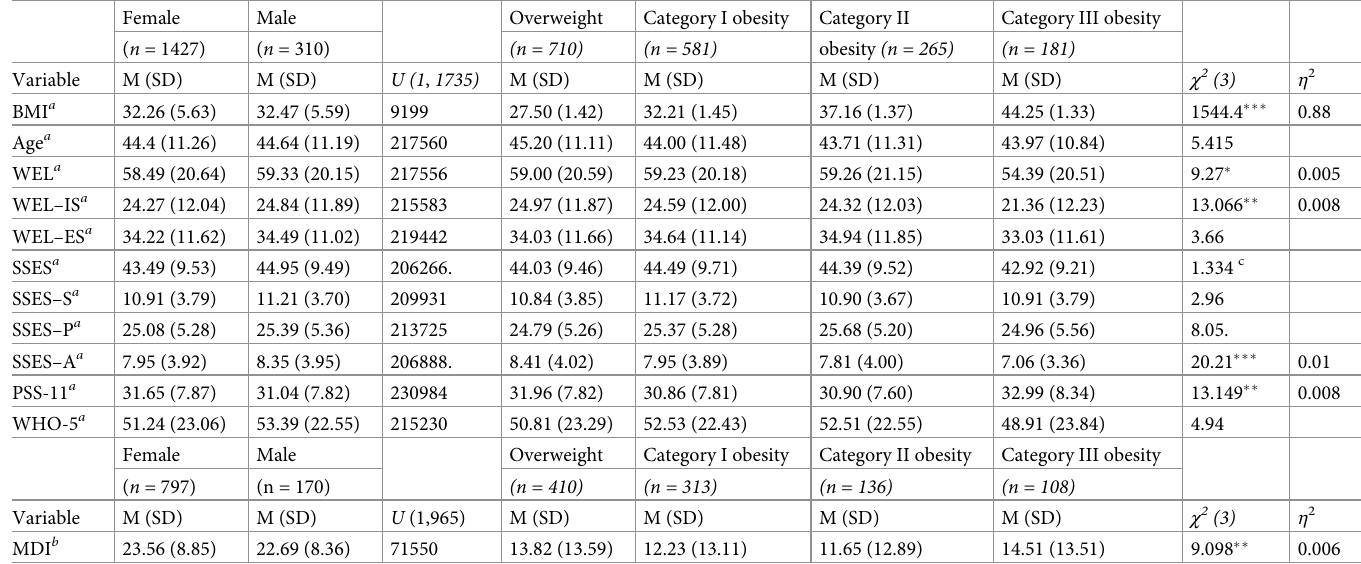
Table 11. Means, standard deviations, Wilcoxon–Mann–Whitney and Kruskall-Wallis statistics for study 2